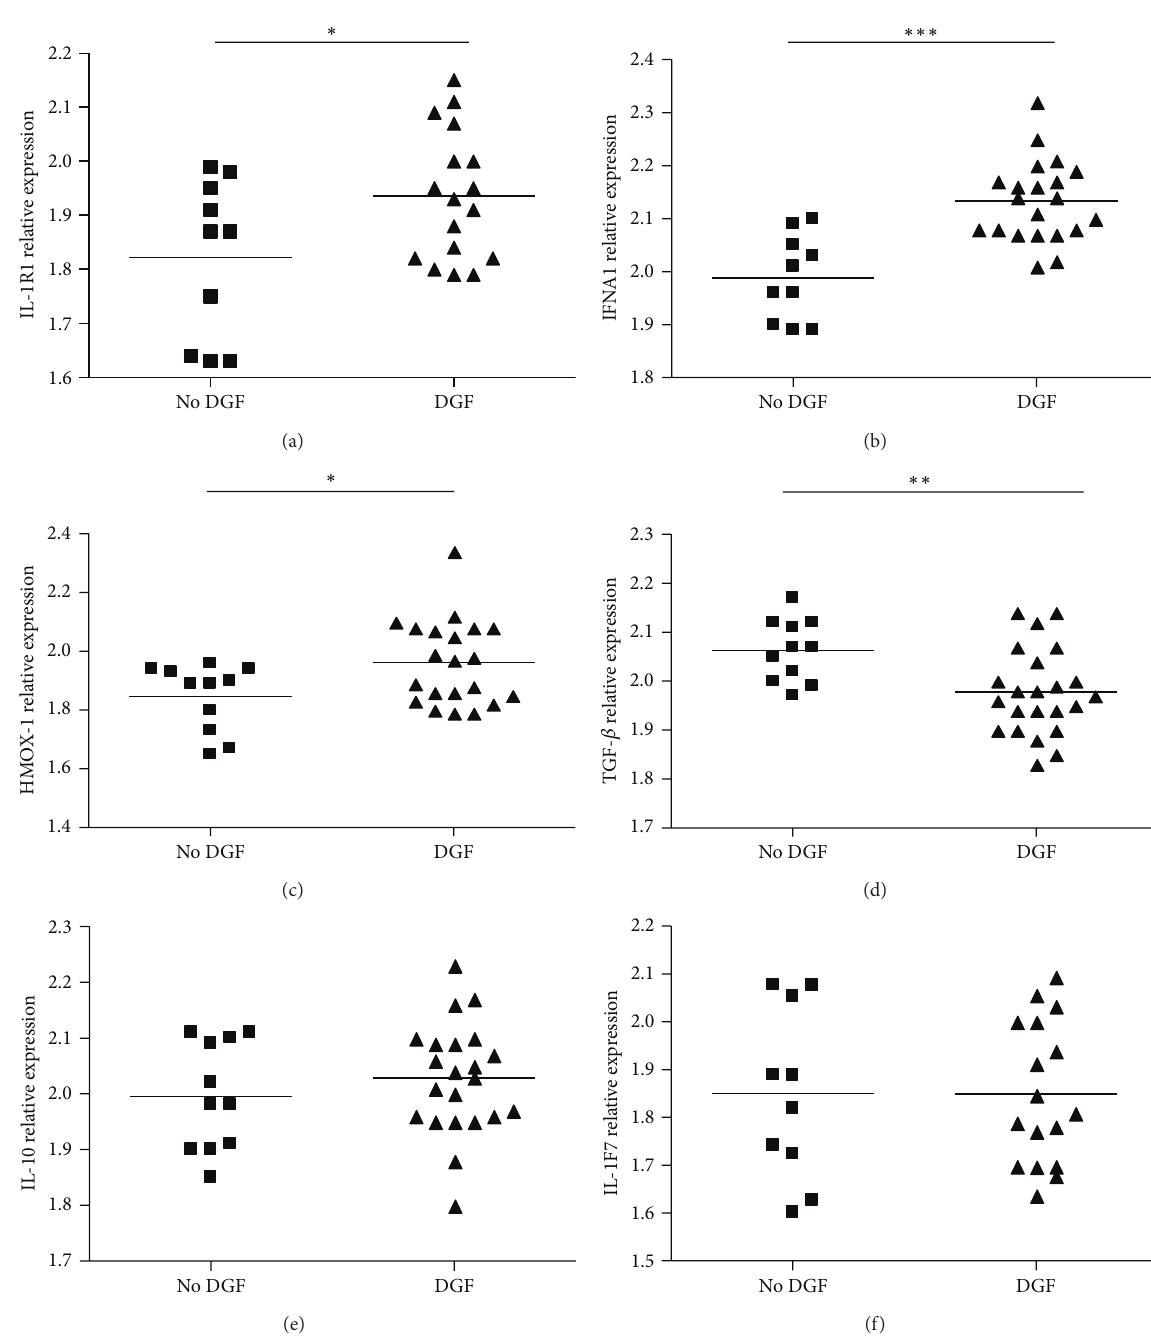
Figure 2: Real-time PCR results evaluating mRNA levels of inflammatory pathway related genes in kidney transplant patients. IL-1R1, IFNA1, HMOX-1, TGF- 𝛽 , IL-10, and IL-1F7 were assayed by real-time PCR in whole kidney RNA samples from no DGF patients and DGF patients. Values were normalized to the level of 𝛽 -actin RNA. Relative expression levels of all genes were calculated as 2 ∧ [(Ct reference gene) − (Ct target gene)]. ∗ 𝑃 < 0.05 , ∗∗ 𝑃 < 0.01 , and ∗∗∗ 𝑃 < 0.001 by Mann Whitney test.